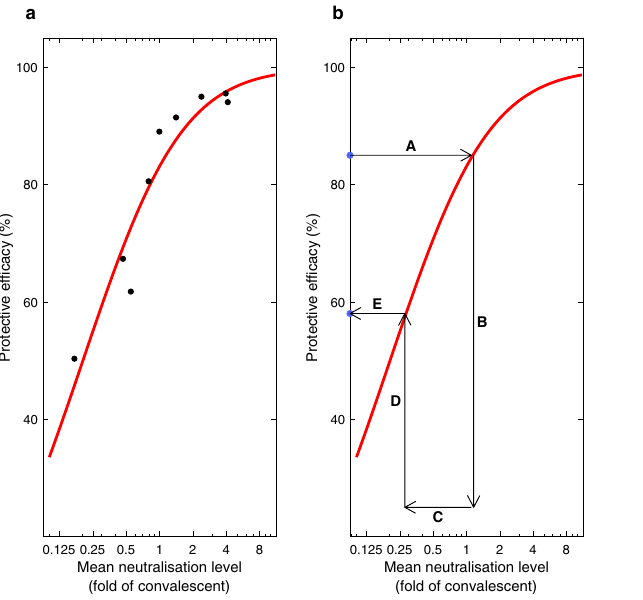
Fig. 5 | Calculation of the impact of shorter dose-interval on vaccine ef fi cacy. a The data (dots) and fi tted curve (red line) from 17 that translates neutralisation level (relative to that for convalescent) to the degree of protection against symp- tomatic disease. b The stepsneeded to scale ef fi cacy for a 12-weekdose intervalto thatforashort3-or4-weekdoseinterval:(stepsA,B)12-weekef fi cacyistranslated to a relative neutralisation level via the red curve 17 ; (step C) neutralisation level is